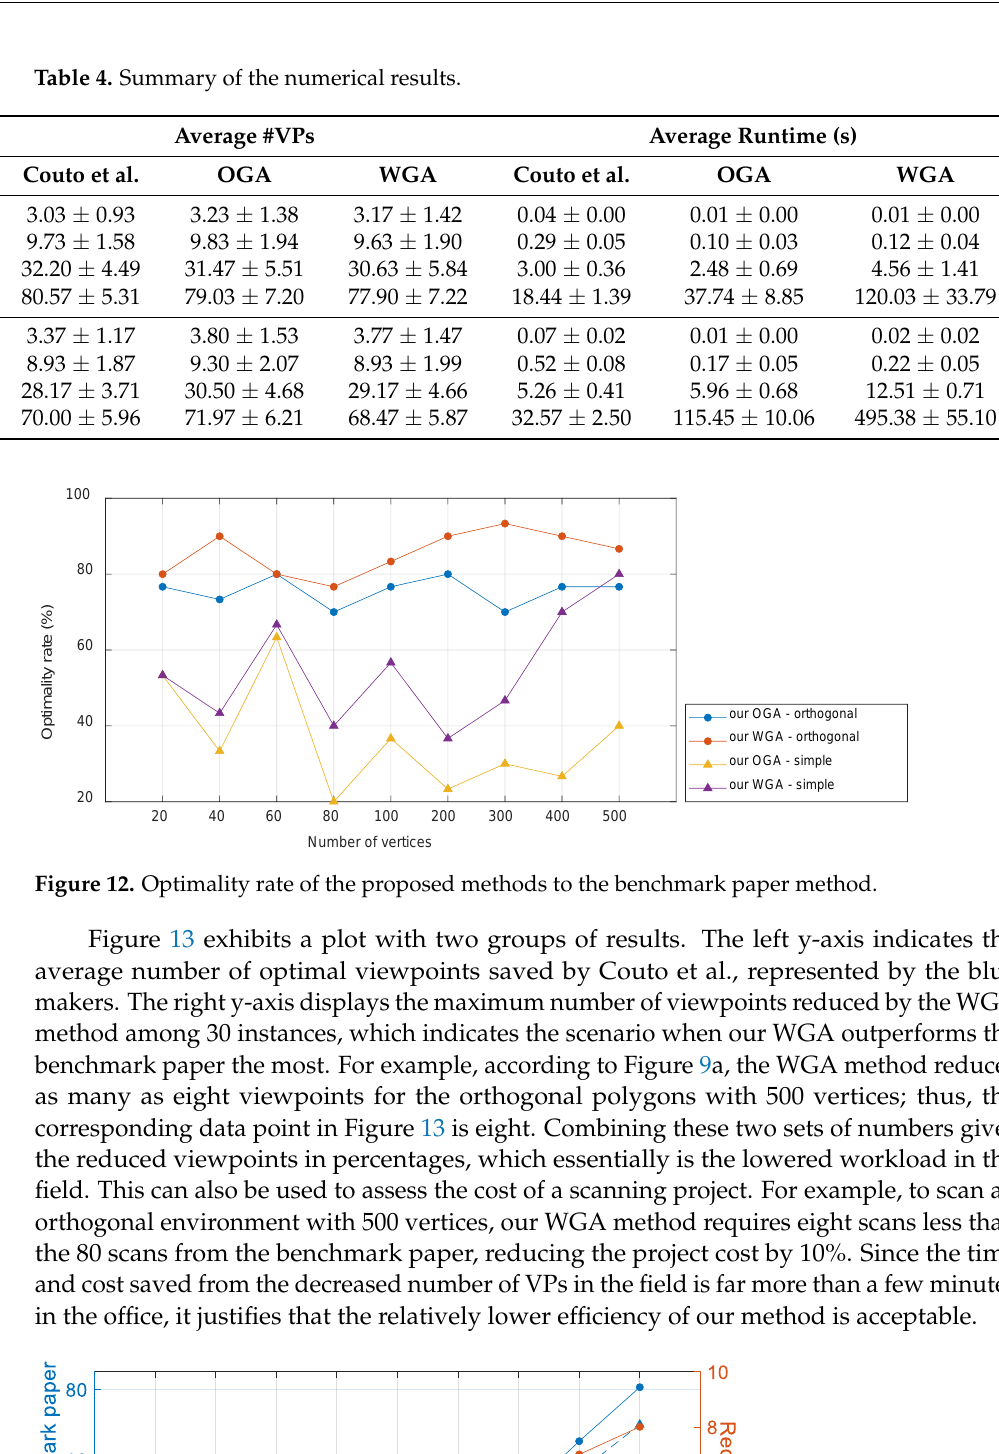
13 Table 4. Summary of the numerical results. Polygon Type #Vertices